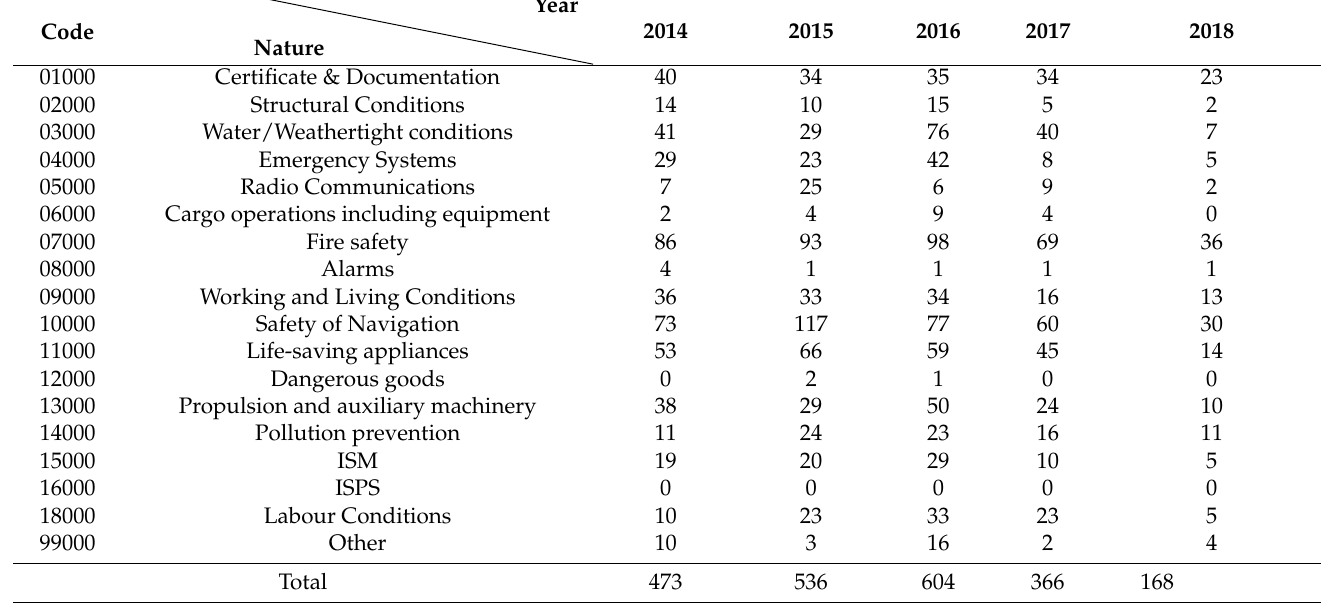
Table A4. Statistics on the deficiencies registered by Taiwanese ships in the Tokyo MoU from 2014 to 2018. Code